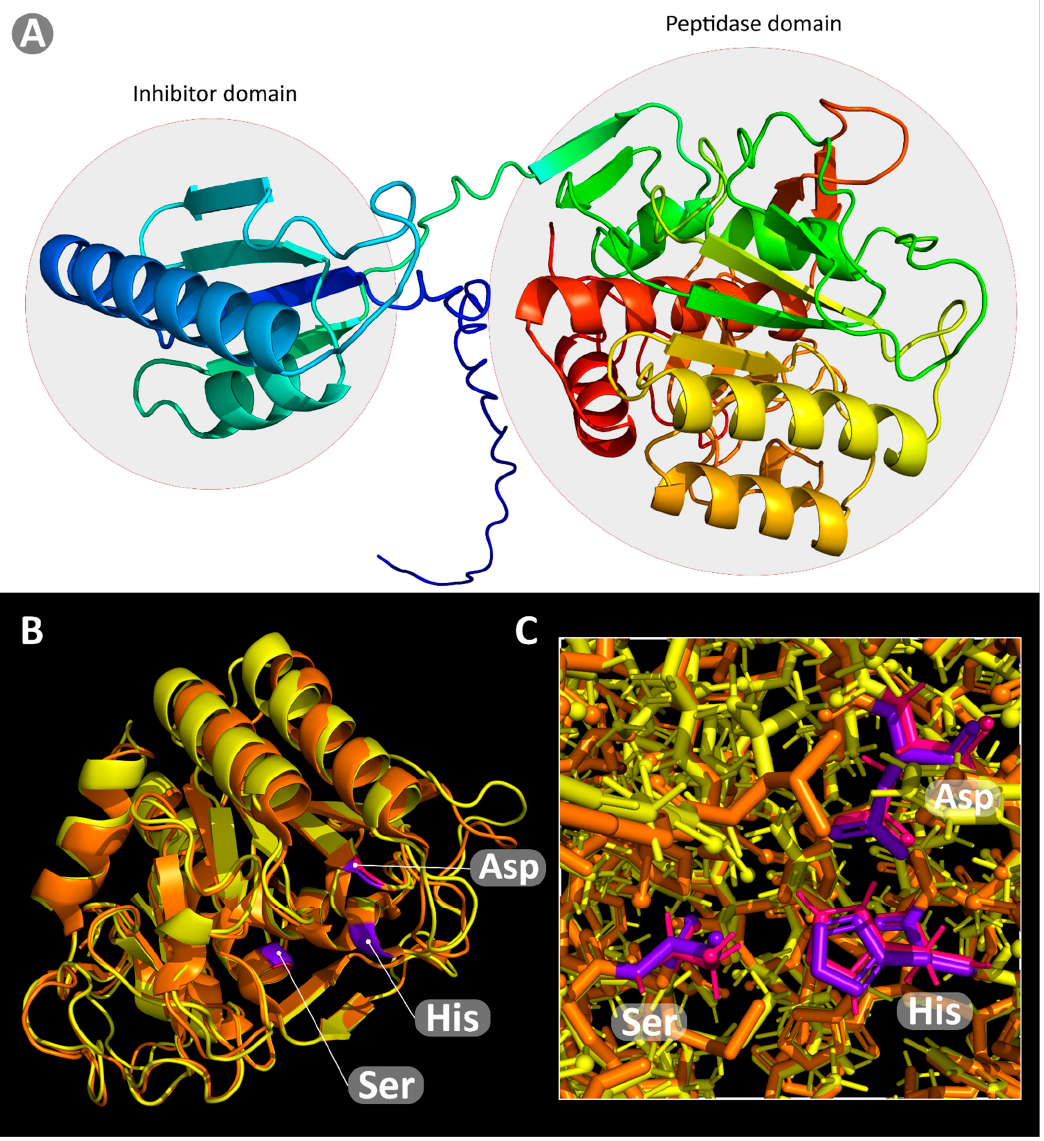
Figure 2. ( A ) Predicted structure of alkaline protease from Aspergillus ochraceus VKM-F4104D. The model is coloured based on a rainbow gradient scheme, where the N-terminus of the polypeptide chain is coloured blue and the C-terminus is coloured red. The structure was predicted with AlphaFold 2.0 [16], and the model with the AlphaFold highest confidence was taken. ( B , C ) Superimposition of the peptidase domains of the predicted structure of Aspergillus ochraceus VKM-F4104D protease (yellow) and the experimentally found structure of Lecanicillium psalliotae protease (PDB ID: 3F7M) (orange) using PyMOL (score 705, RMSD 0.502) [17]. The catalytic residues are coloured hot pink ( Aspergillus ochraceus ) and purple–blue ( Lecanicillium psalliotae ).